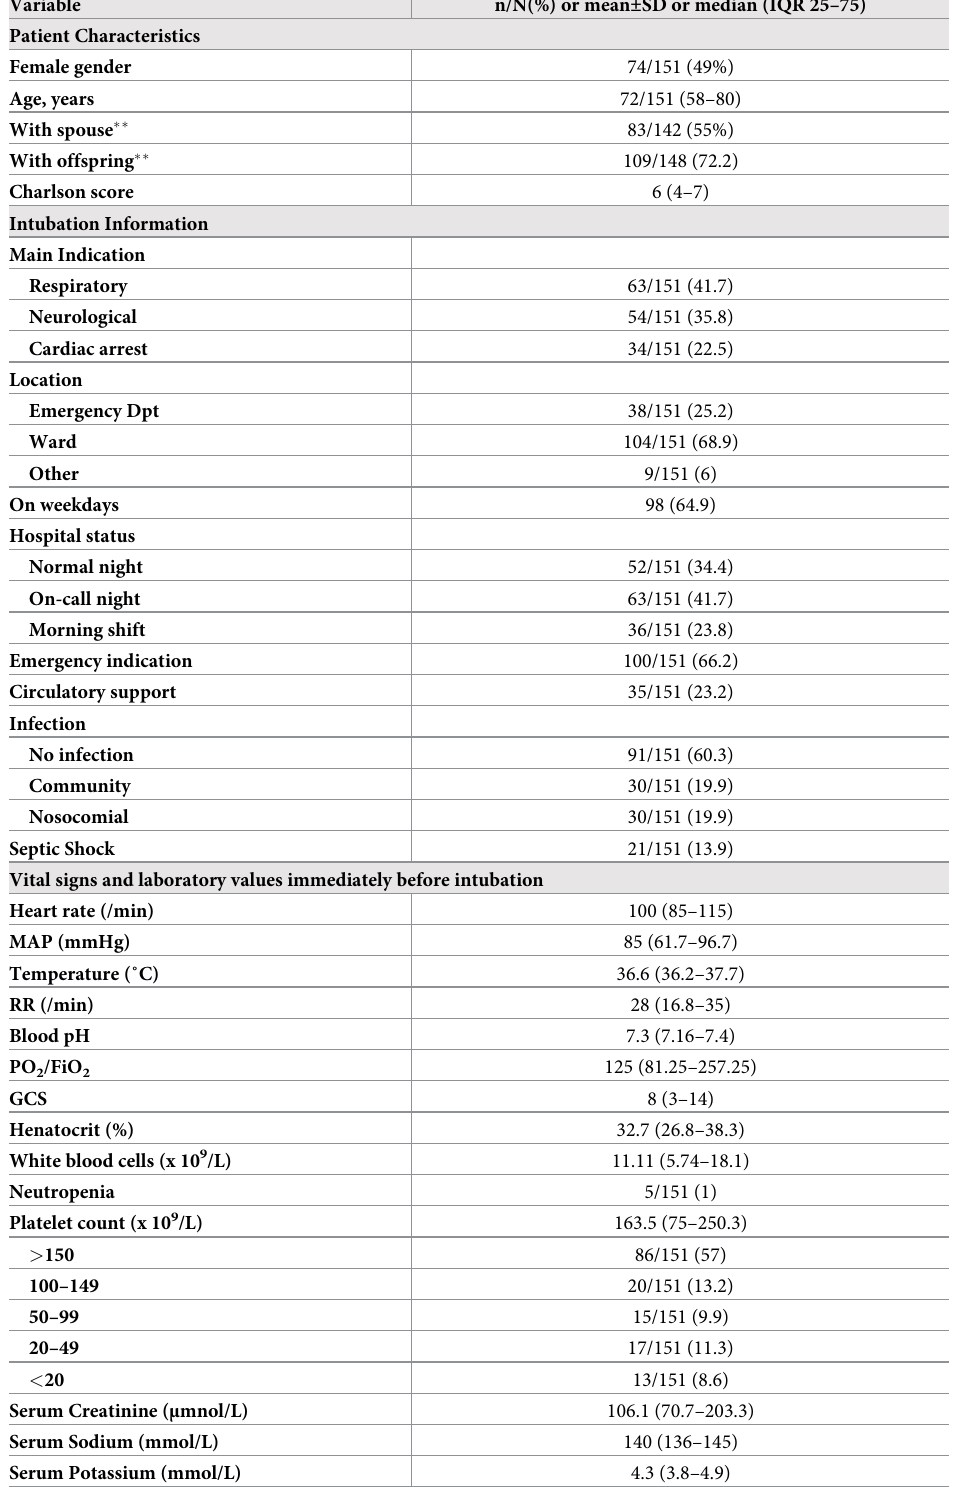
Table 1. Baseline demographic and clinical characteristics of the patient